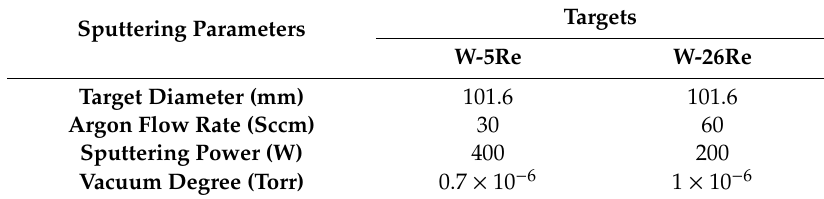
Figure 1. Brief schematic of tungsten-rhenium thin-film thermocouples (TFTCs). Table 1. Sputtering parameters of 95 wt% tungsten–5 wt% rhenium (W-5Re) and 74 wt% tungsten–26 wt% rhenium (W-26Re) thin films.